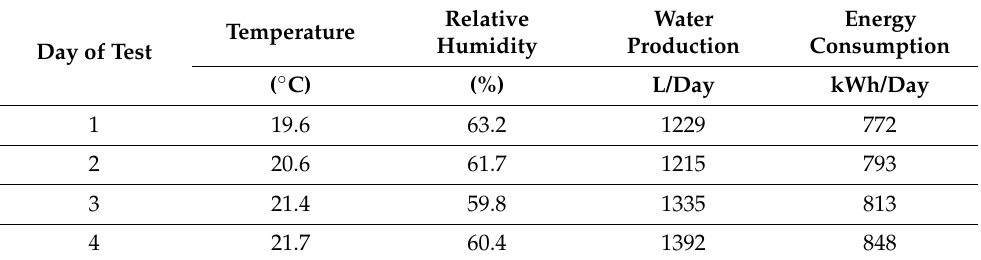
Table 3. Experimental